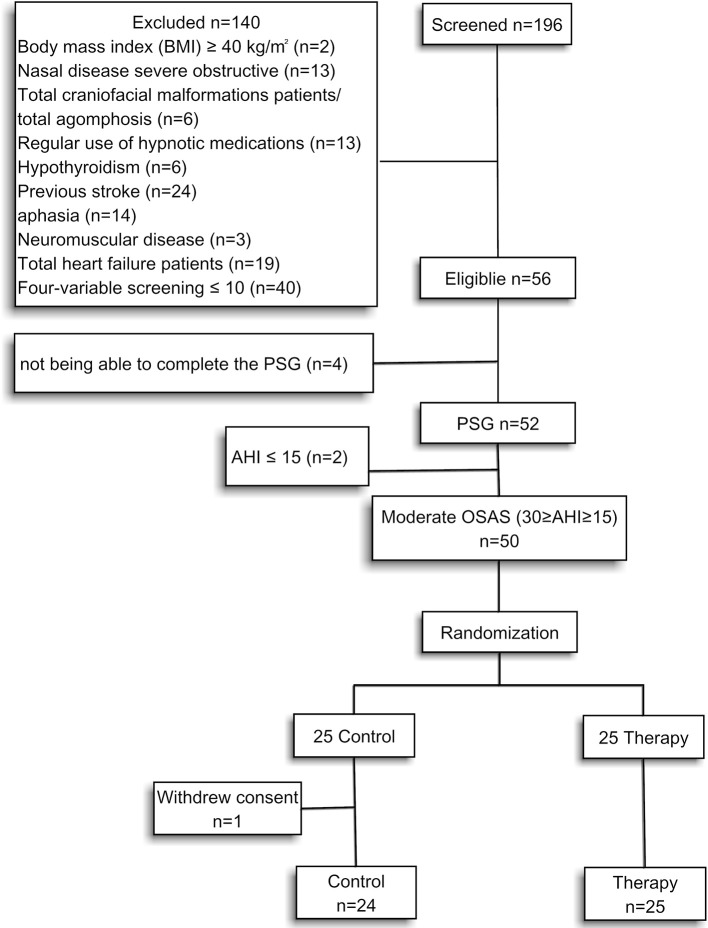
Research design.